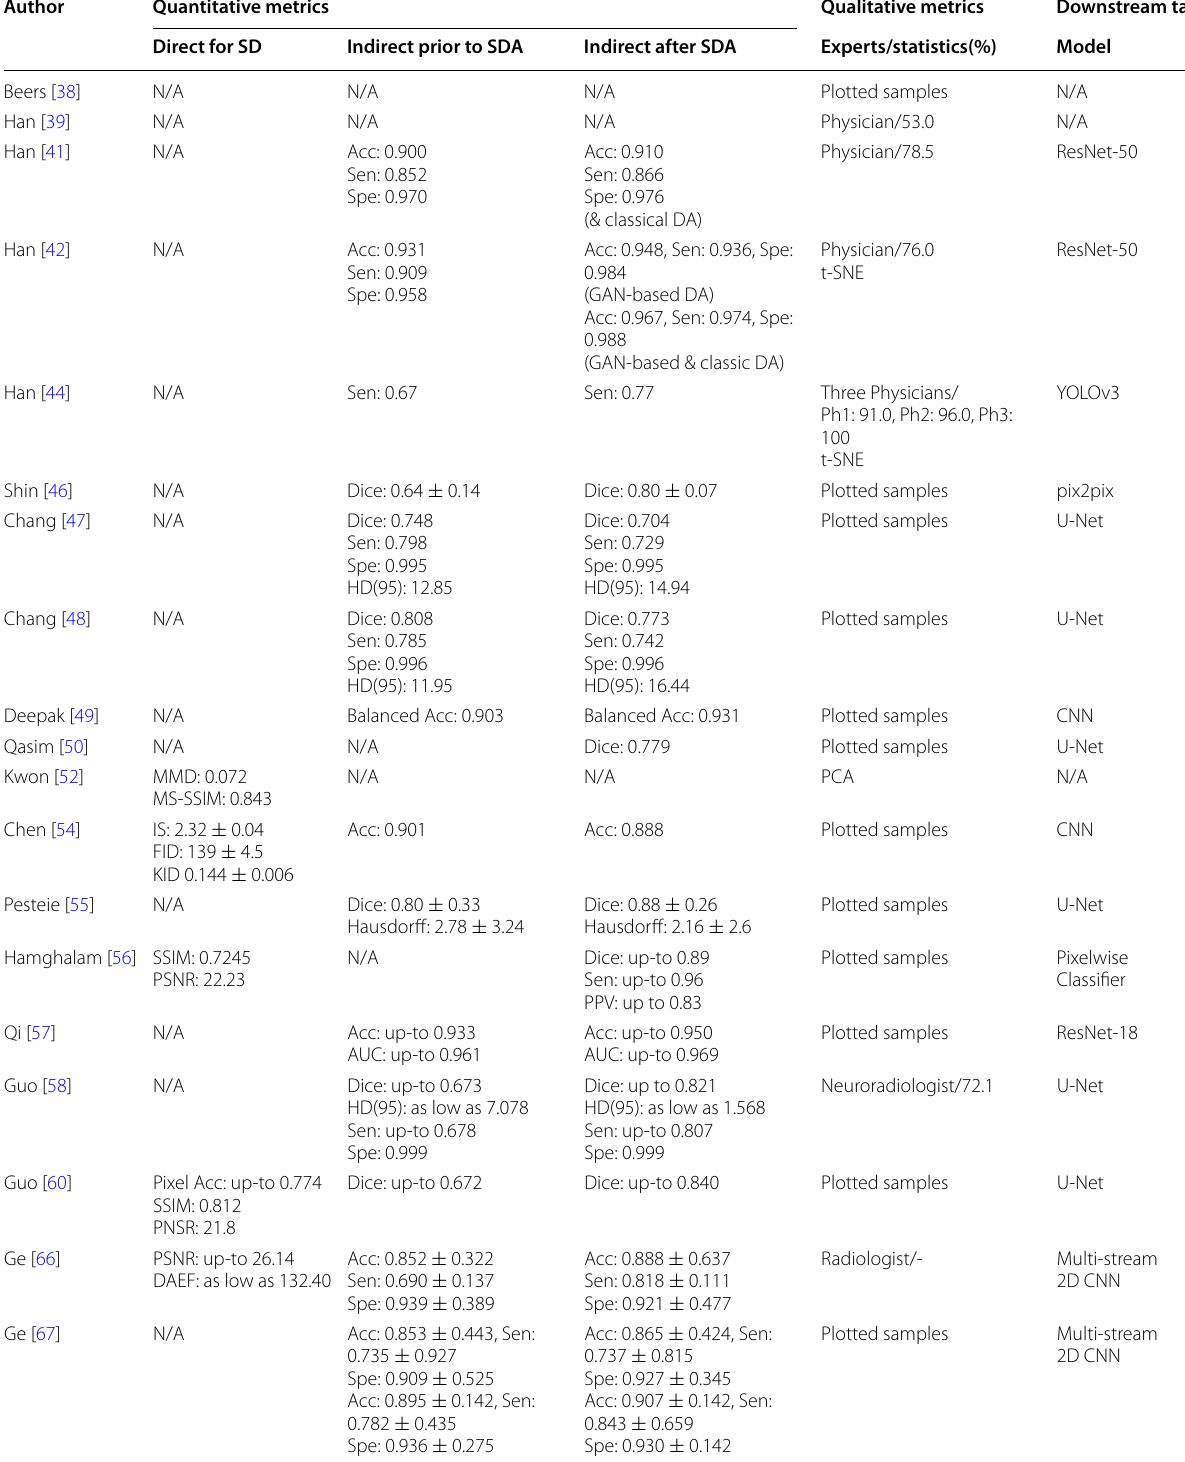
Table 3 Evaluation performance of generative methods presented in the examined studies for brain tumors